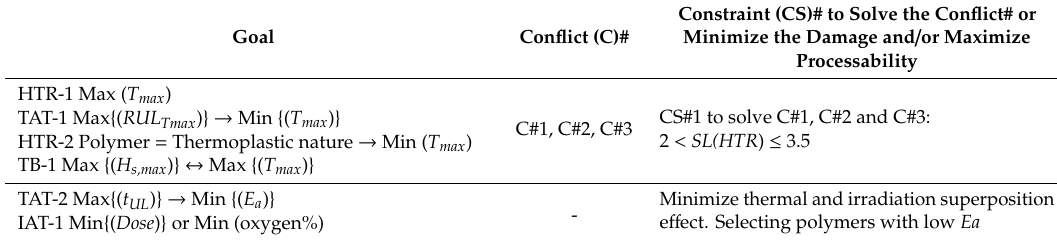
Table 6. Review of the conflicts solving